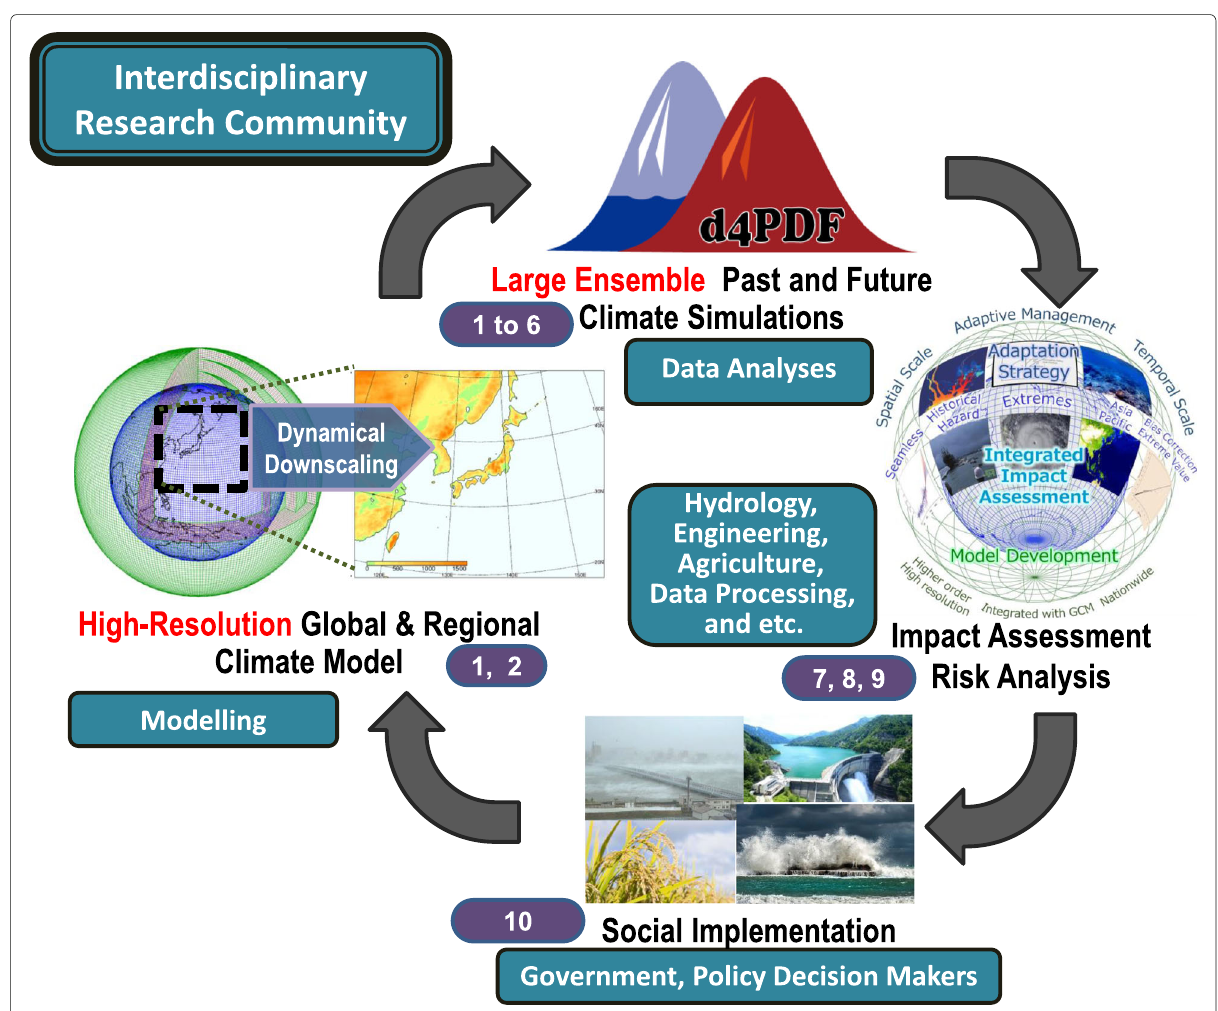
Fig. 1 A schematic view of this review. The numbers denote subsections of the main section temperature (SST), sea ice concentration (SIC), and sea SST2 (Hirahara et al. 2014). Time-varying SIT is con- ice thickness (SIT). The greenhouse gas concentrations structed and given as SIT monthly climatology (Bourke of CMIP5 (Taylor et al. 2012) were fed into the models. and Garrett 1987) multiplied by the observed SIC. Future In the past climate simulation, observed SSTs, SIC, and simulations were performed assuming climatologically SIT were used, where the SSTs and SIC are of COBE- constant warming conditions of +1.5 K (Nosaka et al. Table 1 Subsets of climate simulation experiments in d4PDF under different climate conditions. (cid:2) T in the forth column means differences in past and future climatologies of SST and SIC computed from CMIP5 RCP8.5 experiments by six climate models